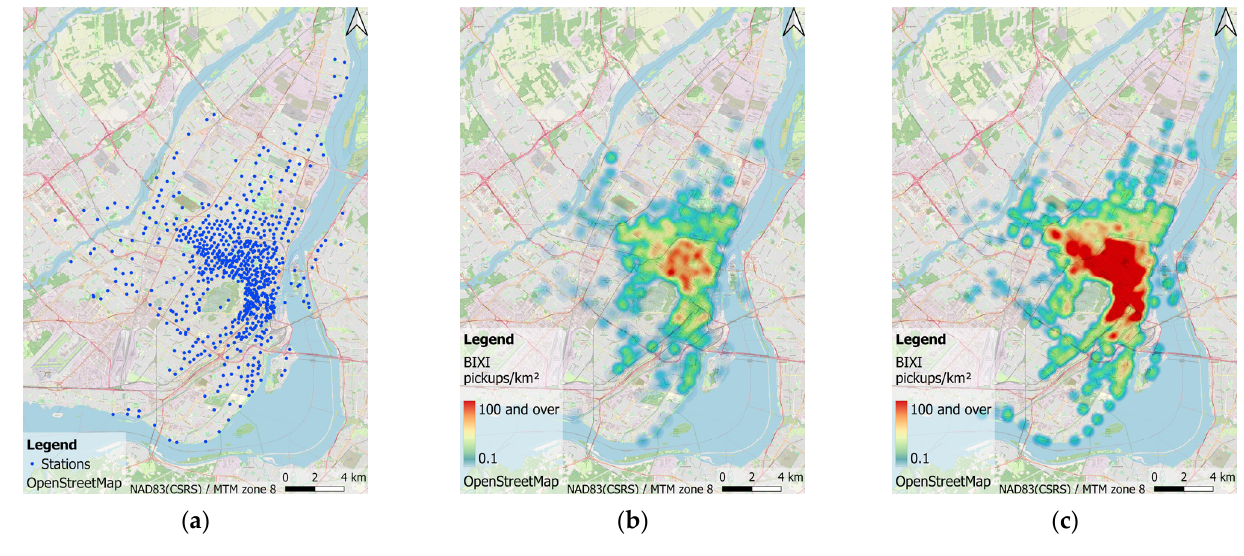
Figure 1. Spatial and temporal distributions of BIXI stations and pickups in Montreal. ( a ) Spatial distribution of BIXI stations; ( b ) Cumulative BIXI pickups heatmap, 6:00–7:00 September 2020; ( c ) Cumulative BIXI pickups heatmap, 14:00–15:00 September 2020. The bike-sharing data between 15th April and 31st October from 2017 to 2020